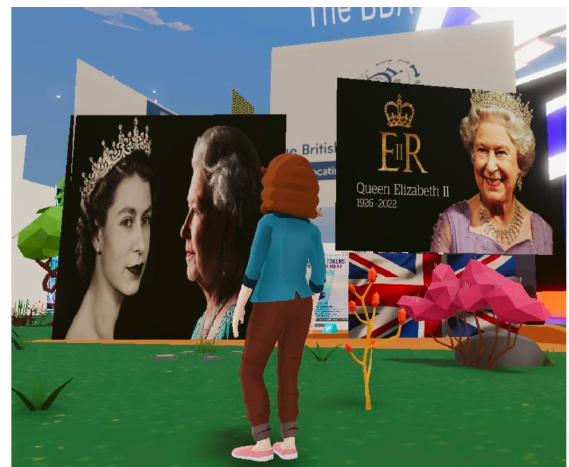
Figure 9: Official national mourning, The Queen, BBA’s Metaverse Headquarters, 10 September